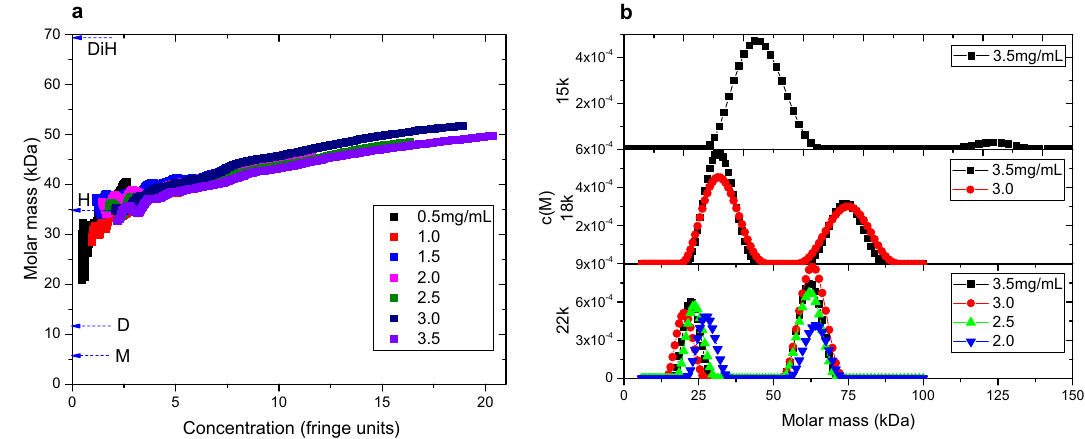
Figure 7. Output from SEDFIT-MSTAR c(M) analysis of IGlu measured with AUC-SE. ( a ) Point-average, apparent molar mass measured across the cell with overlapping plots from the concentration range 0.5–3.5 mg/ mL). Monomer, dimer, hexamer and dihexamer have been labelled M, D, H and DiH, respectively. ( b ) c(M) distribution analysis from multi-speed experiments (15k, 18k, 22k revolutions per minute), where peaks were suitably